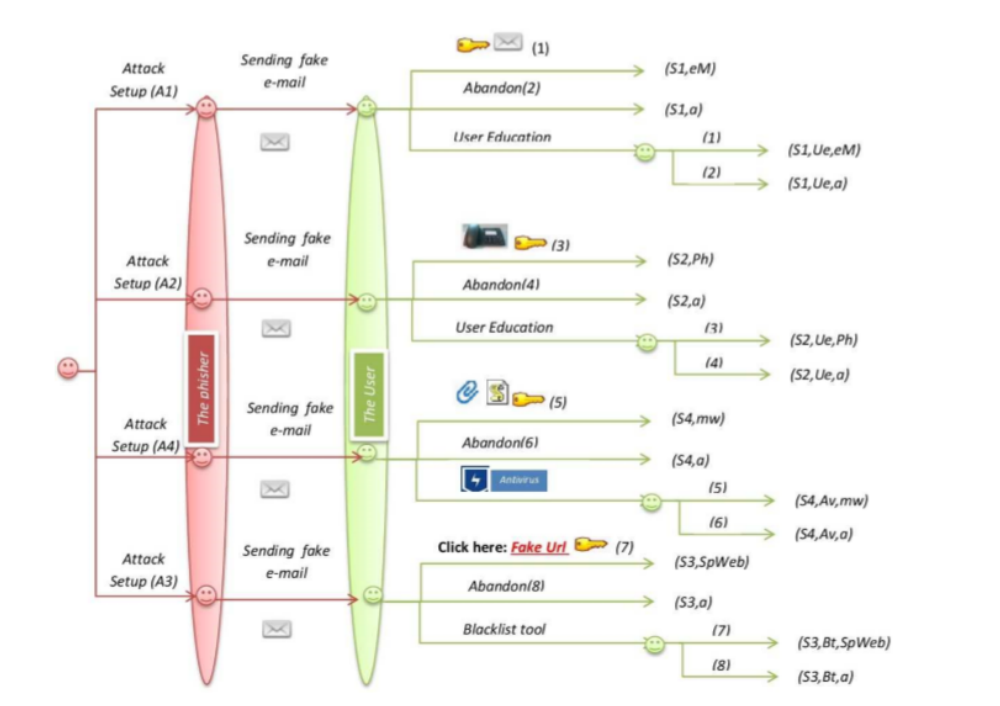
Figure 1. Interactions’ scenarios between the attacker and the user. Table 1. Game’s